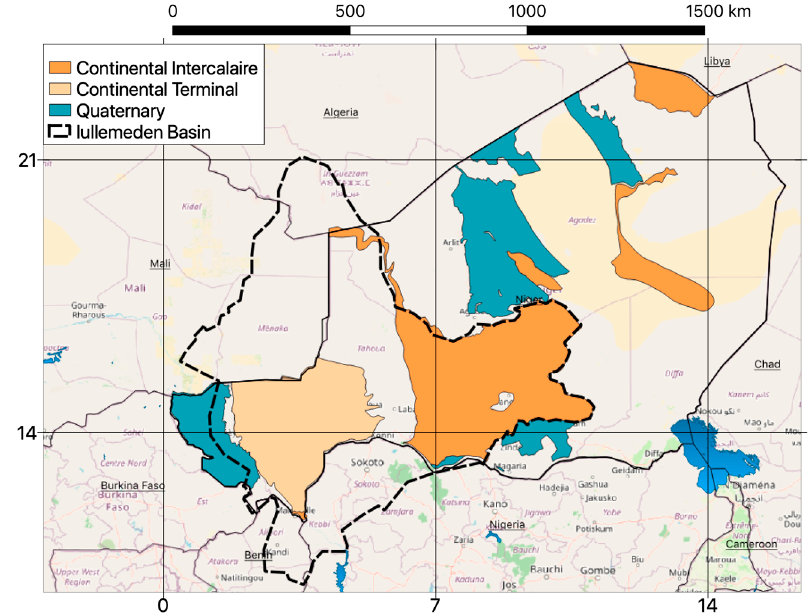
Figure 2. Principal shared aquifers in the Iullemeden Basin.